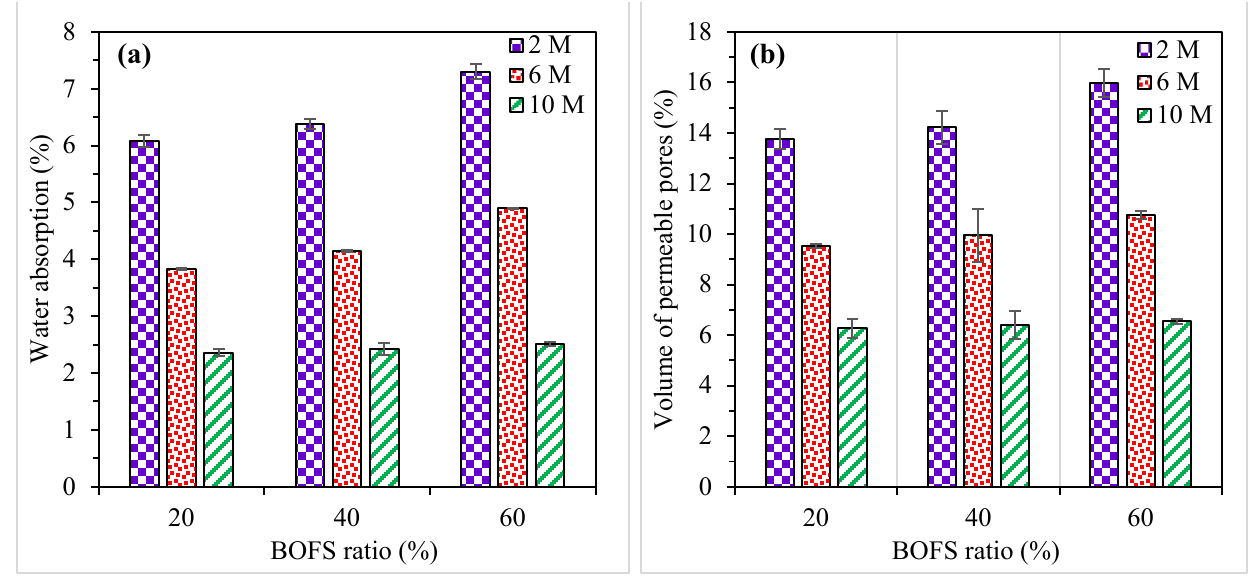
Figure 8. ( a ) The variation in the water absorption and ( b ) volume of permeable pores of AAM specimens.